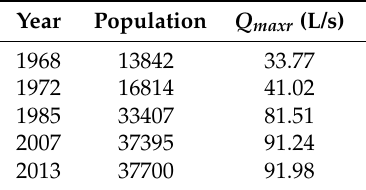
Table 1. Population and required maximum flow for the Oruro southern